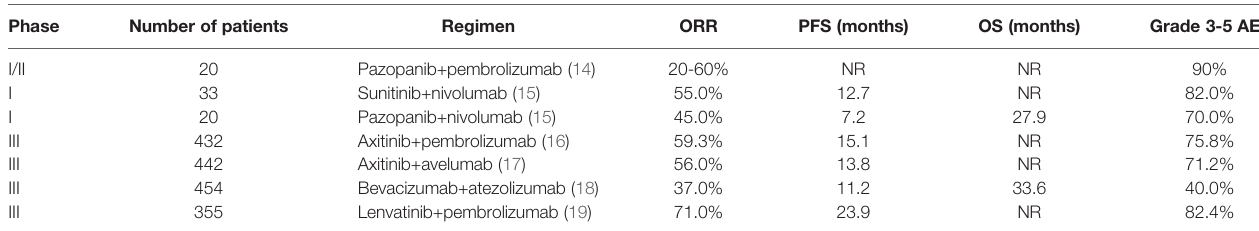
TABLE 1 | Summary of clinical trials evaluating the combination of PD-1/PD-L1 inhibitors plus different anti-angiogenesis agents in treatment-naïve mRCC.